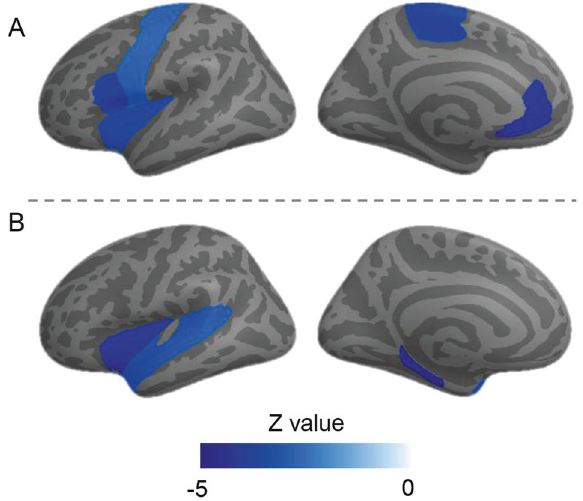
Fig. 1 Cortical maps of associations between cortical thickness, state anhedonia and the polygenic risk score for anhedonia, rendered on the left hemisphere. A Regions associated with state anhedonia; B Regions associated with the polygenic risk score for anhedonia. Only regions survived multiple comparisons correction were shown. Negative Z values indicate cortical thinning in brain